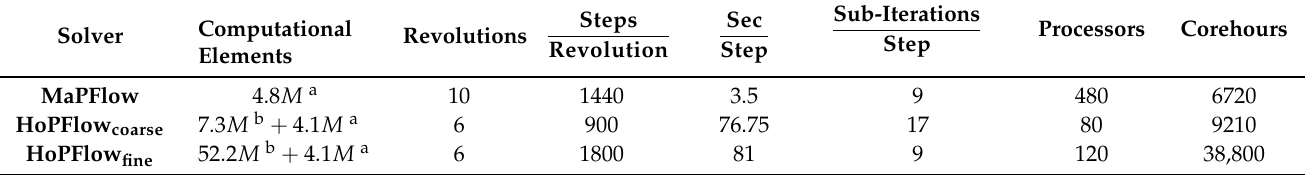
Table 9. Computational cost comparison between Eulerian and hybrid solver simulations.